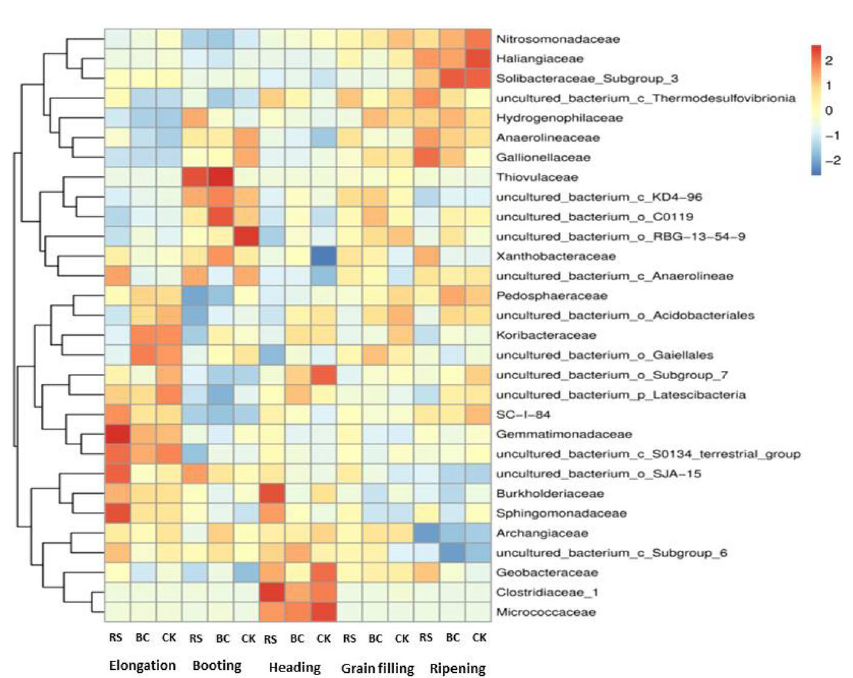
Figure 5. Relative abundance of top 30 genera in the treatment groups using R language (R v 3.1.1, https:// devel oper- platf orm. biocl oud. net/#/ Micro bial/ taxon omySp ecies/ abund ance_ chart) to construct a species abundance heat map. Relative abundance is the correlation between species and treatments, with red representing a positive correlation and blue a negative correlation Treatments: RS rice straw applied at 9000 kg ha −1 , BC biochar applied at 3150 kg ha −1 , CK soil without straw/biochar